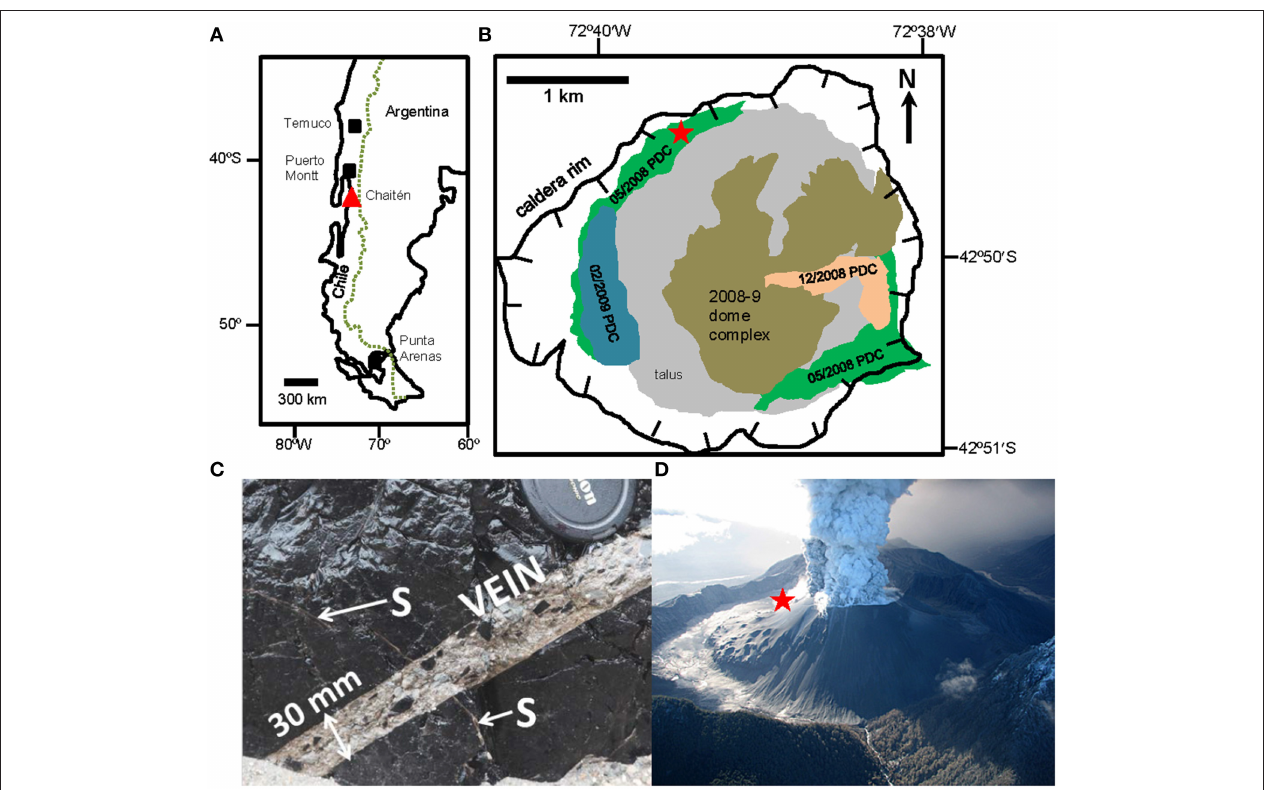
FIGURE 1 | (A) The location of Chaitén volcano in the Southern Volcanic Zone of the Chilean Andes. (B) Simplified map of the 2008-9 deposits within the Chaitén caldera, after Pallister et al. (2013). Distribution and dates of pyroclastic density current (PDC) deposits indicated. Bomb sampling location indicated (star). (C) Part of the studied tuffisite vein, with subsidiary veins indicated (S). (D) The eruptive plume on May 26 2008, during the transitional phase, showing newly-emplaced lava flows (to the left) and sampling location (star). Photograph by J.N. Marso, USGS.